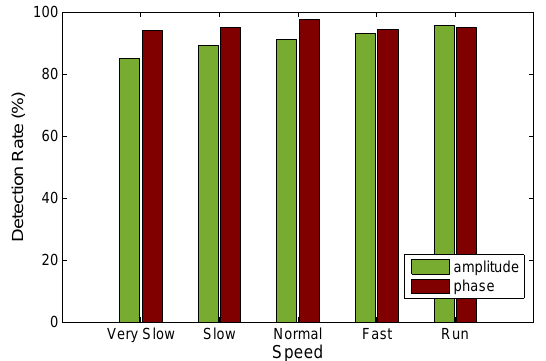
Figure 13. Detection rate of human motions with different movement speed.